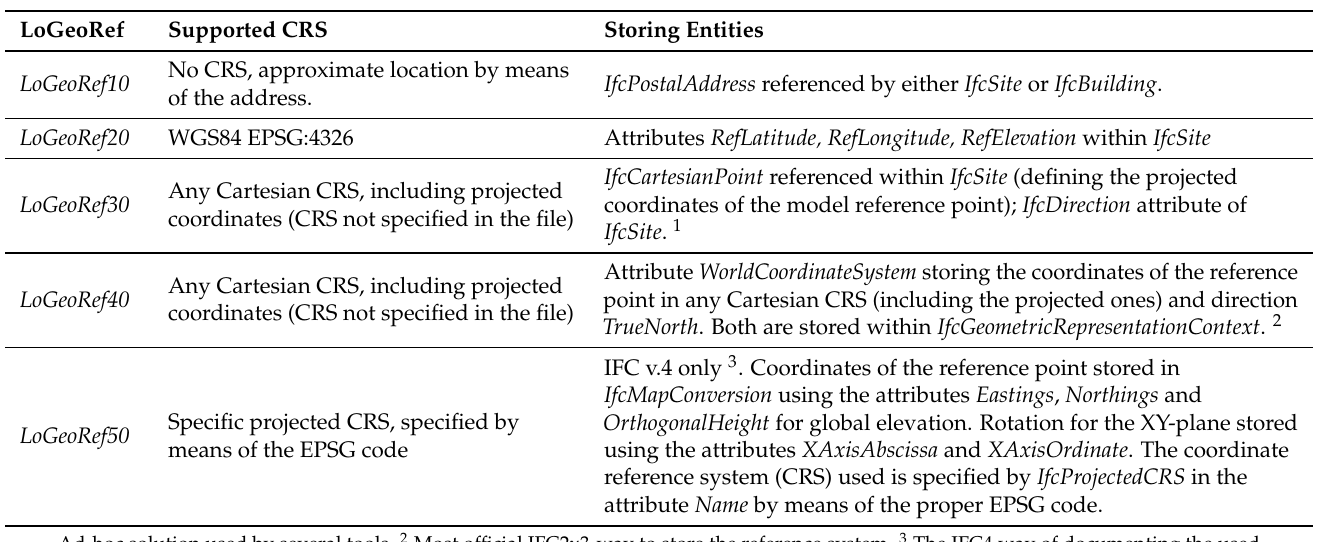
Table 1. Synthesis of LoGeoRefs as defined by Clemen and Görne